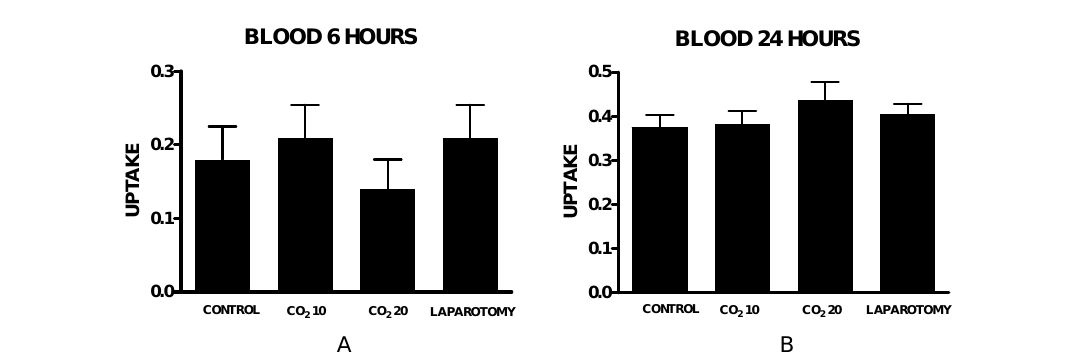
FIGURE 1 - Technetium-99m uptake in the blood after six hours (A) and 24 hours (B). Each bar represents the mean ± SEM of six animals. There were no statistically significant variations between the